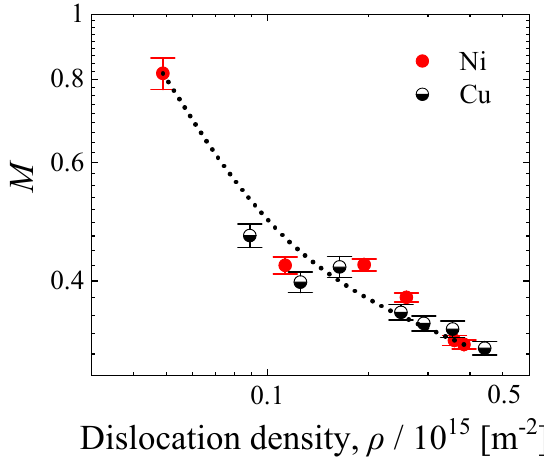
Figure 12. Influence of varying dislocation density on M values for Ni and Cu specimens.